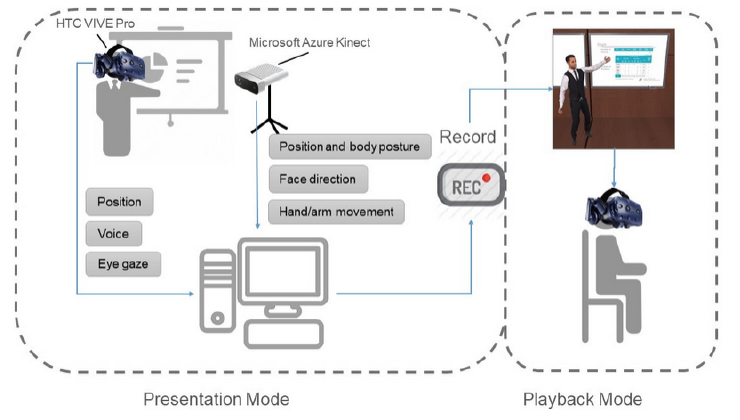
Figure 2. General architecture of the VR public speaking training system (Note that the HMD was not used during the presentation in the experiment).